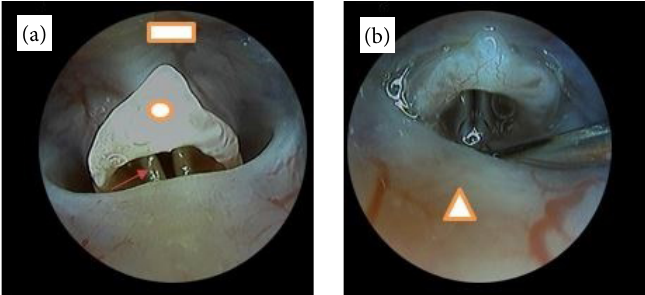
Figure 2 - Endoscopic images of the rat hypopharynx and larynx. (a) In posterior decubitus in a nearly horizontal position, the vallecula is visible in the superior aspect of the image ( square ), followed by the epiglottis ( circle ). The arytenoids ( arrow ) can be easily mistaken for the true vocal folds. The true vocal folds lie deep to the base of the epiglottis and visualization can become difficult without appropriate anesthesia. This is due to the reflex movement of the epiglottis. (b) The posterior fold of mucosa ( triangle ) represents the soft palate. In the supraglottic region, sputum may be visible and may impair